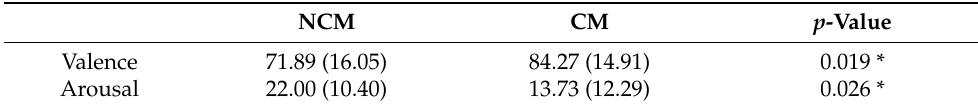
Table 2. Judgments of the valence and arousal of music excerpts in the non-concussed music (NCM) and concussed music (CM)